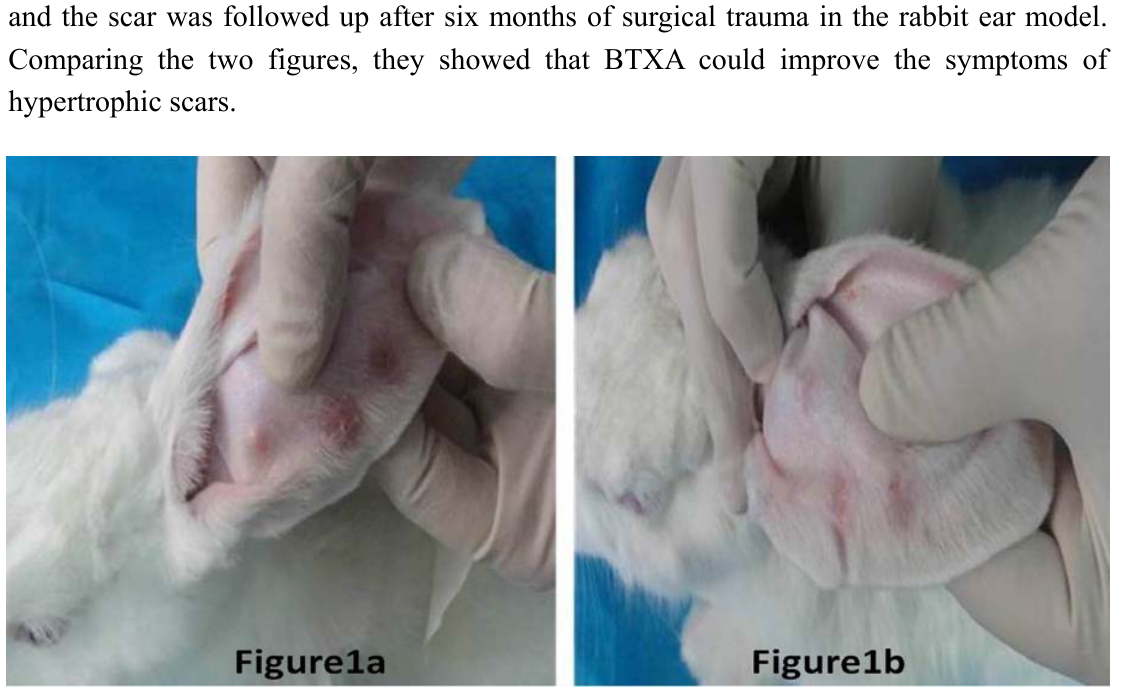
Figure 1. Hypertrophic scar in the rabbit ear. Figure 1a represents the hypertrophic scar